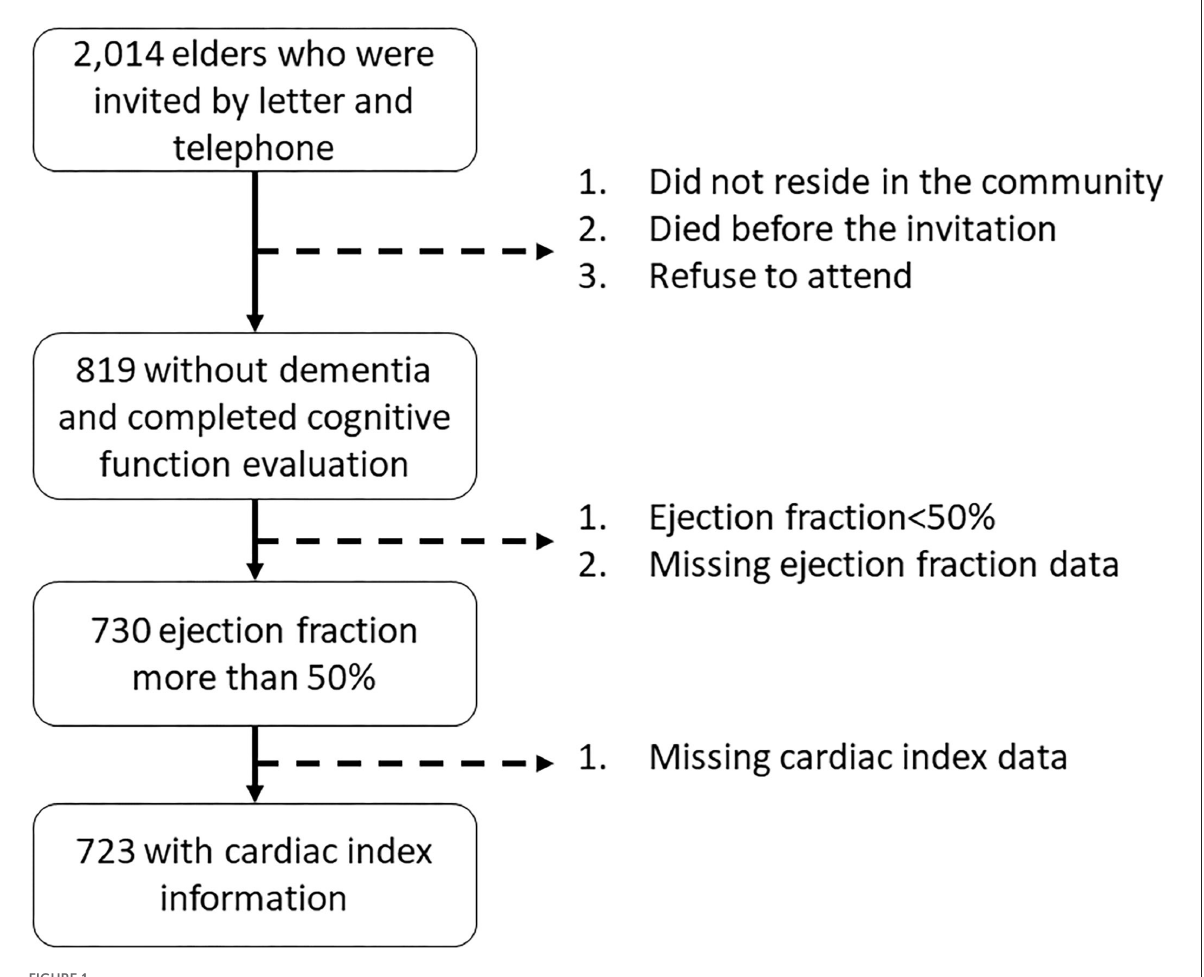
FIGURE1 Study population